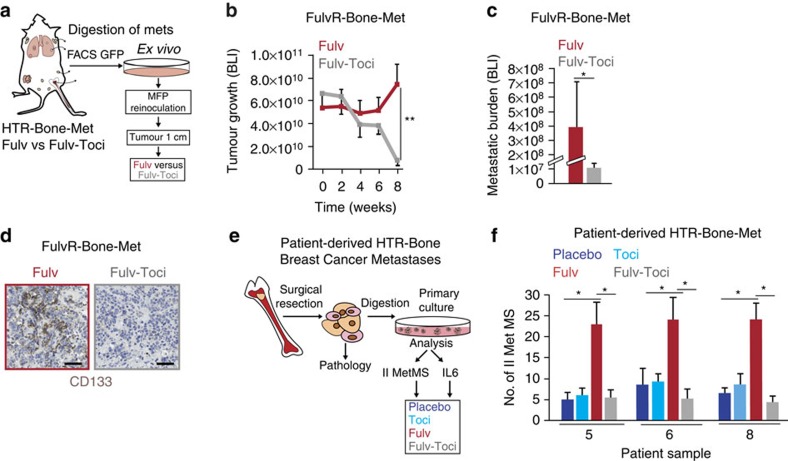
IL6R blockade re-sensitizes HTR metastasis to HT and reduces CD133.(a) Schematic of the experimental plan: (1) metastatic cells were isolated via FACS (GFP+) from mice with bone metastases resistant to Fulv (MCF7 derived-FulvR-B-Met, Supplementary Table 2); (2) cells were propagated ex vivo for 2 weeks and re-inoculated in the MFP of a new cohort of mice; (3) when tumours reached ∼1 cm diameter, mice were randomized to receive Fulv in the presence/absence of tocilizumab. (b,c) Tumour/metastatic growth/burden assessed using BLI of FulvR-Bone-Met-bearing mice treated with Fulv and Fulv-Toci. The mean BLI value±s.e.m. is reported for each time point (n=5 mice per group). (d) Representative CD133 IHC images and histological examination of tumour tissues derived from b (scale bar, 50 μm). (e) Schematic of the experimental design for the generation of patient-derived bone metastatic cultures (HTR-Bone-Met, Supplementary Table 3). (f) Secondary MS growth (Number-No-of II MetMS >100 μm) of patient-derived HTR-Bone-Mets (samples 5, 6 and 8) treated with vehicle (Placebo), Fulv (10 μM, 7 days), tocilizumab (Toci, 50 μg ml−1, 7 days) and Fulv-Toci (7 days). Data are reported as mean±s.d. of three independent experiments (n=3; f). P values (*P<0.05, **P<0.0001) refer to t-test (c), t-test after GLM ANOVA (f) and post hoc t-test corrected for multiple comparisons after GLM for repeated measures (b).